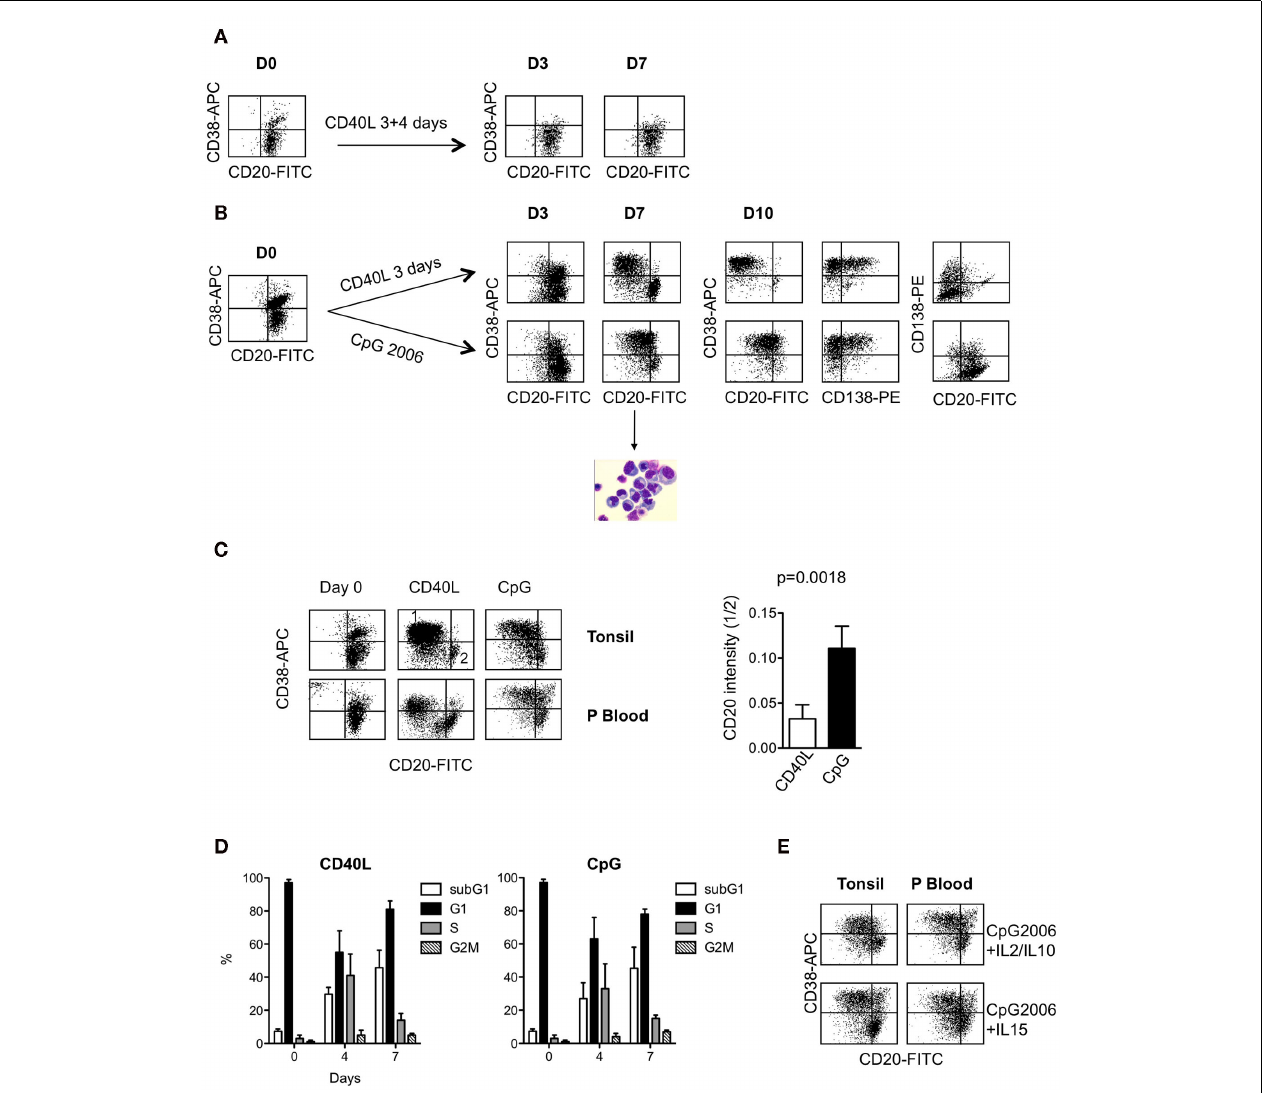
representative experiment performed with one tonsil (three others were performed with three other independent donors). (C) Comparison of PCs generated from tonsil or peripheral blood CD27 + B-cells cultured in the presence of CpG2006. CD27 + B-cells (D0) were cultured as described in (B) , and their phenotypes were analyzed at Day 7. Region 1 delineates CD38 + CD20dim/ − PBs, and region 2 delineates CD38 − CD20 + B-cells. Right: the relative CD20 intensity in PBs at Day 7 was expressed as the ratio representative of CD20 MFI in CD38 + PBs (region 1) divided by the CD20 MFI of the remaining B-cells CD20 + CD38 − (region 2). Five independent experiments were performed with CD27 + B-cells purified from four tonsils and one peripheral blood sample. (D) Cell cycle analysis of the differentiation of CD27 + B-cells cultured as described in (B) . Histograms represent the proportion of cells in the subG1, G1, S, and G2M phases. SubG1 proportion was defined on the whole population. For G1, S, and G2M phases, the proportion was defined after exclusion of subG1 peak (Modfit).The data represent the mean ± SD of three independent experiments performed with three independent donors. (E) Comparison of CD20 + PB generation after CpG2006 stimulation in the presence of IL2 plus IL10 or IL15. CD27 + B-cells (tonsil or peripheral blood) were cultured as described in the legend of Figure 1B , with IL2 plus IL10 or with IL15.The phenotypes of the PBs were analyzed at Day